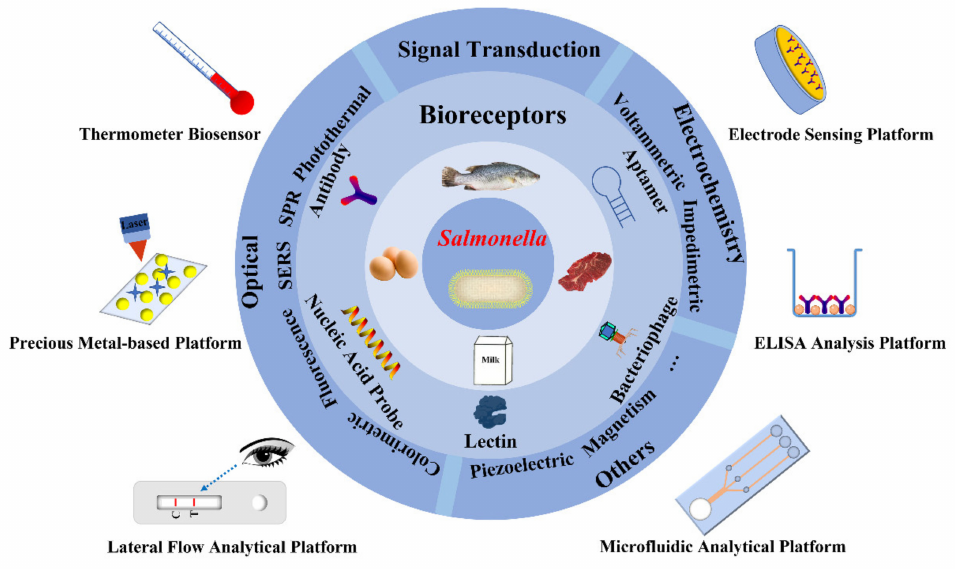
Figure 1. Overview of the bioreceptors and rapid detection methods for Salmonella